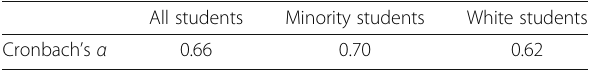
Table 9 Reliability statistics for motivations to pursue STEM majors